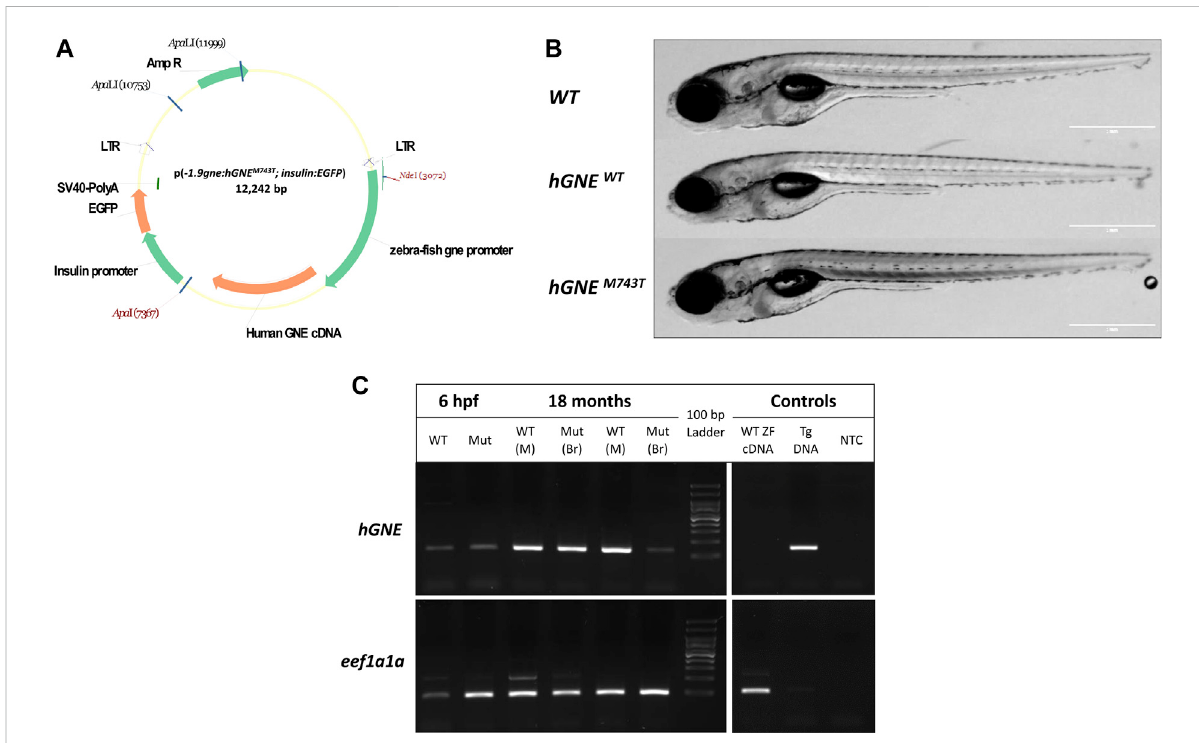
FIGURE 1 Generation of hGNE M743T/WT transgenic lines. (A) A schematic representation of the p(-1.9 gne :hGNE M743T/WT ; insulin :EGFP) plasmid. Genes, promoters, LTRs, polyadenylation signal and restriction sites are indicated. (B) The hGNE transgenic lines develop normally. The fi gure presents bright fi eld images of a WT (top), hGNE WT transgenic (middle), and hGNE M743T transgenic (bottom) larvae at 8 dpf. Scale bar = 1 mm. (C) RT-PCR analysisof hGNE mRNAexpressionin hGNE M743T and hGNE WT transgeniclines.AgarosegelelectrophoresisofRT-PCRampli fi cationproductsof the hGNE gene (top) and eef1a1a (bottom) as the internal control. Both the hGNE M743T (Mut) and hGNE WT (WT) cDNA samples show the expected ampli fi cationinalltestedtimepointsandtissues.Non-transgenicWTzebra fi shcDNA(WTZFcDNA)andgenomicDNAfromtransgenic fi sh(TgDNA) served as controls for each target. (NTC) no template control, (M) Muscle, (Br) Brain